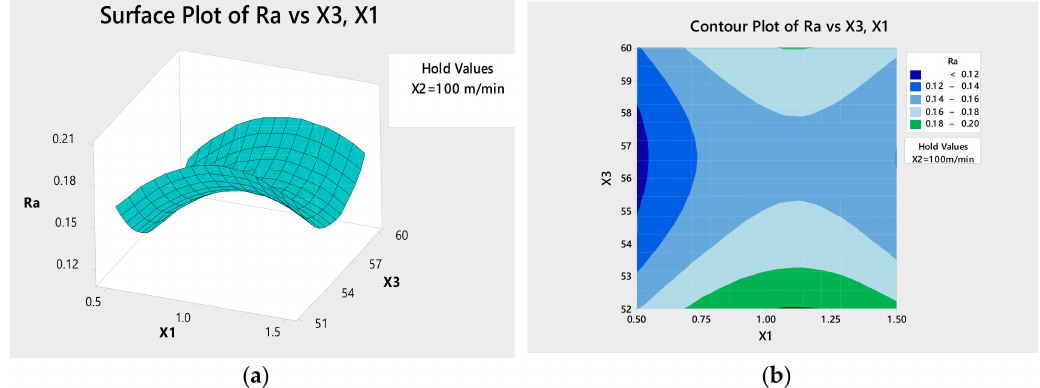
Figure 5. The e ff ects of nano concentration and hardness on surface roughness R a .